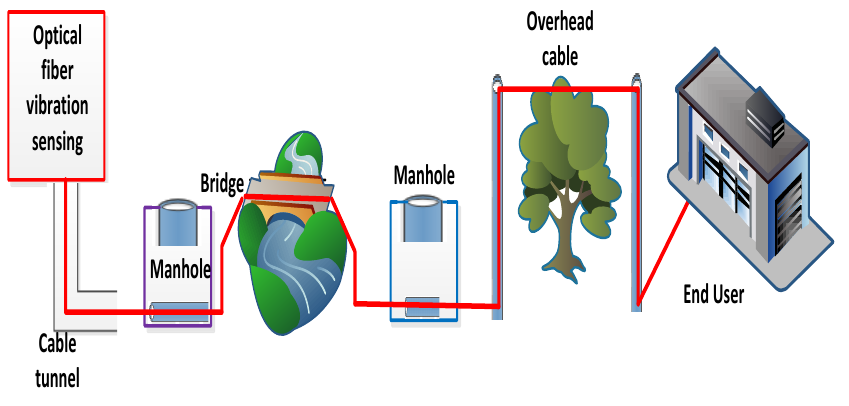
Figure 1. The installation of optical fiber communication system and external disturbance which creates losses inside the optical